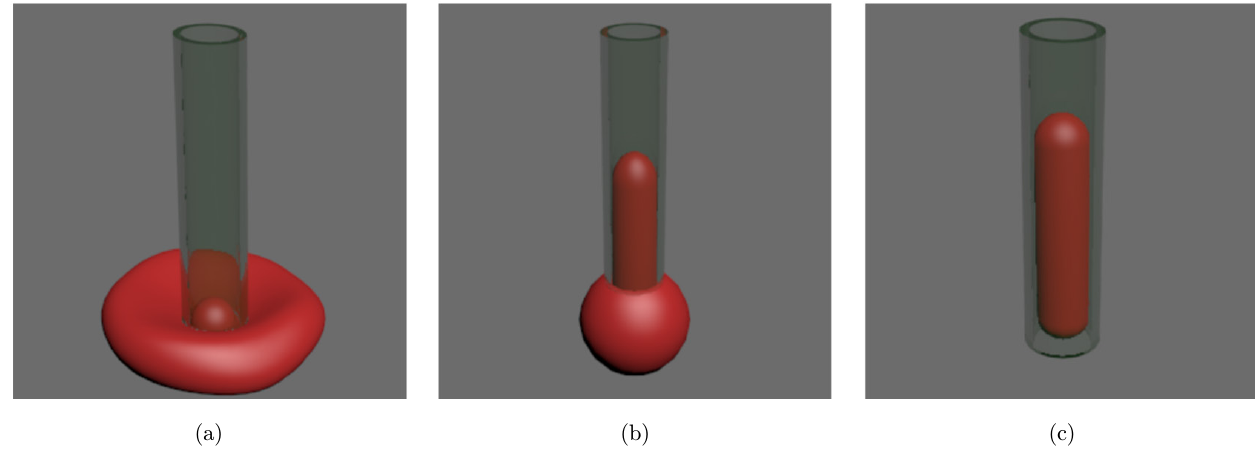
Fig. 3. Schematic of micropipette aspiration on erythrocyte. (a) Aspiration of a small hemispherical portion of erythrocyte membrane-skeleton. (b) An aspired tongue of erythrocyte membrane-skeleton within the micropipette. (c) An aspiration of the whole erythrocyte into the